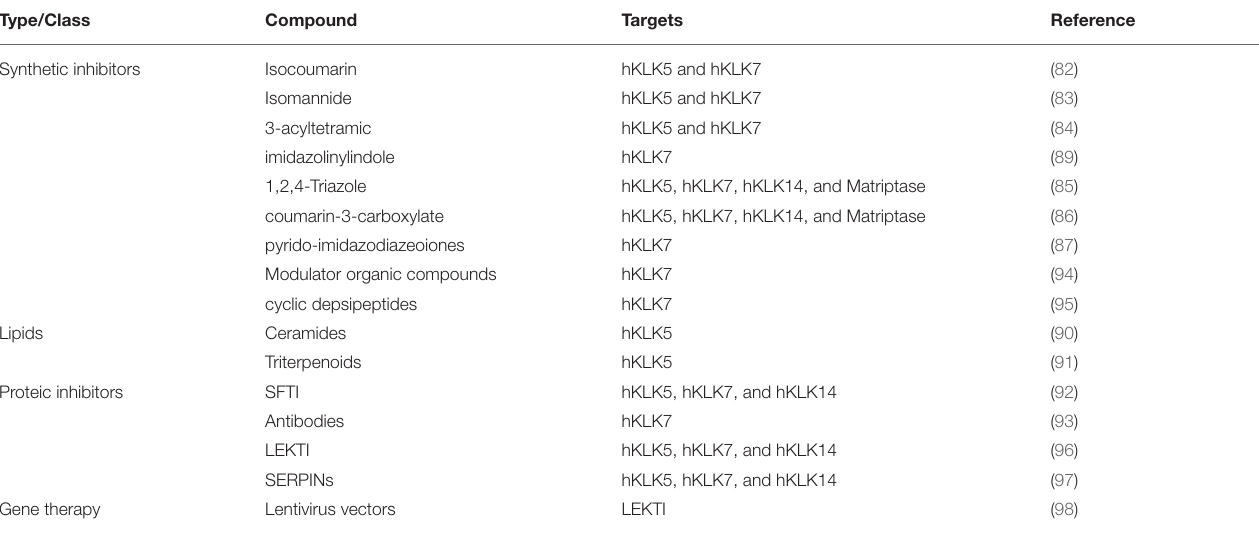
TABLE 1 | Kallikrein inhibitors with potential therapeutic